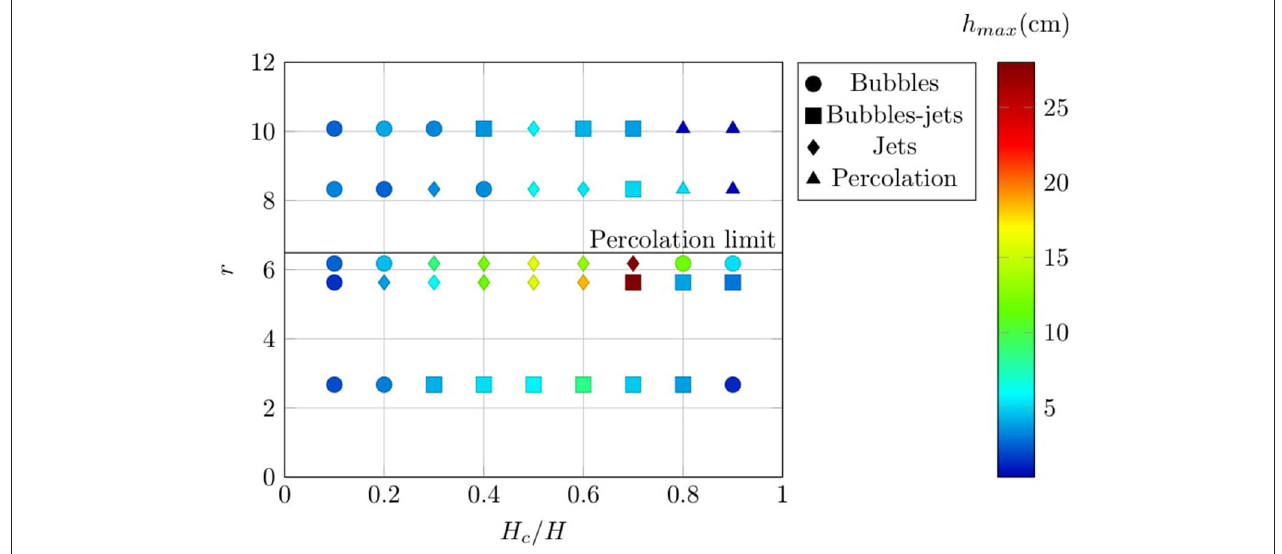
FIGURE 4 | The observed activity type in two-layer planar beds for different particle size ratios r , different coarse layer thicknesses ( H c ) and constant total bed thickness ( H ) of 10cm. Colours indicate the maximum height particles are ejected above the top of the bed (h max ). The nine points for r = 6.18 correspond to experiments where both layers were formed from a mixture of two particle sizes (bimodal); all other data are for experiments with unimodal layers. The percolation limit, i.e., the value for r above which small particles can move through the interstices of large particles, is 6.5 (Yu and Standish,